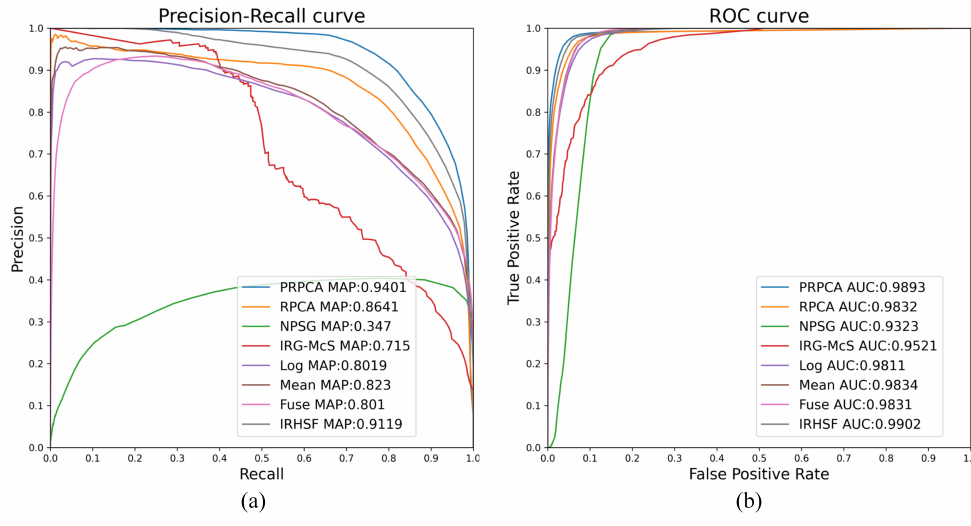
Figure 9. ROC and PR curve results of the image pair with a large lesion. ( a ) PR curve; and ( b ) ROC